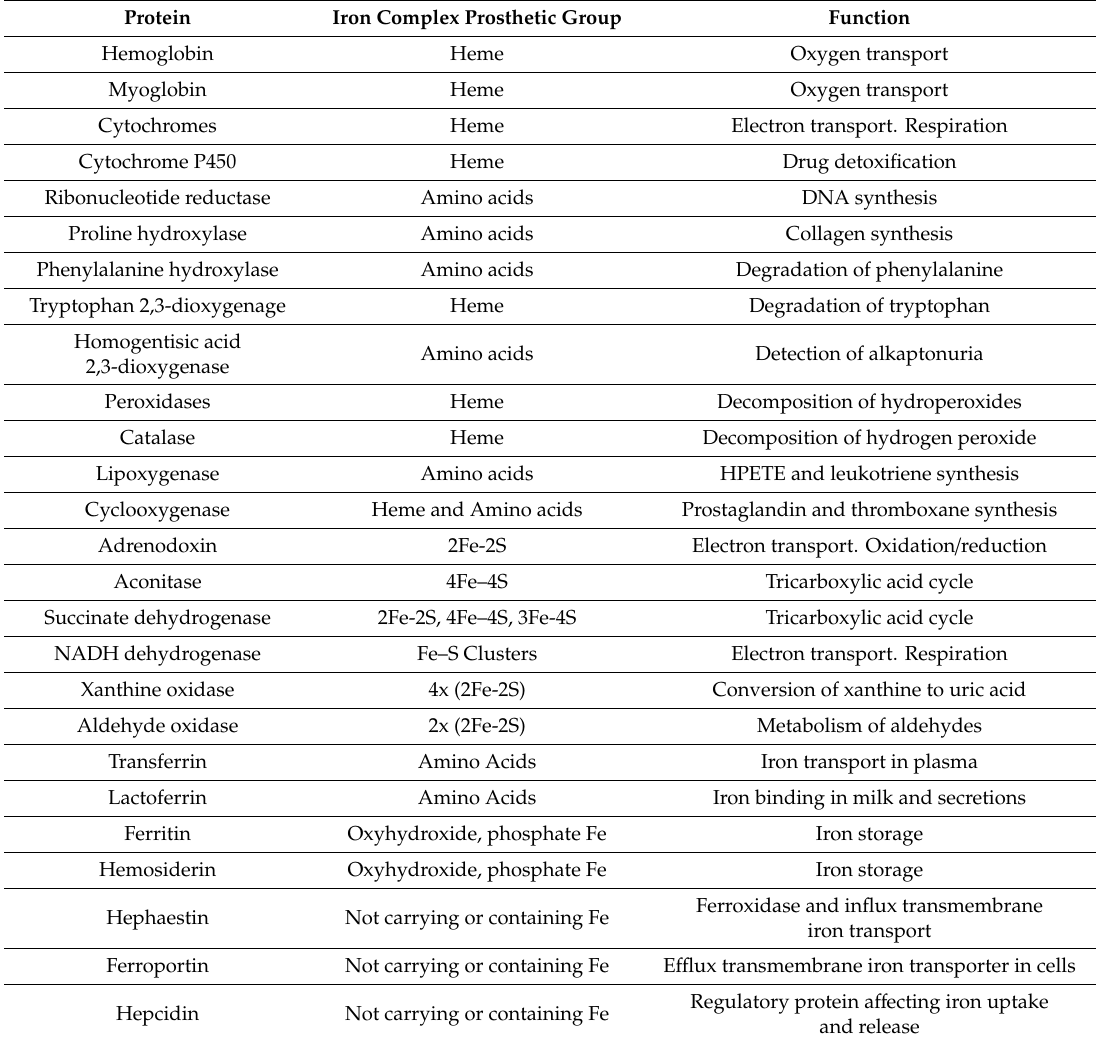
Table 1. Examples of iron-containing proteins with the type of the iron complex prosthetic group and protein